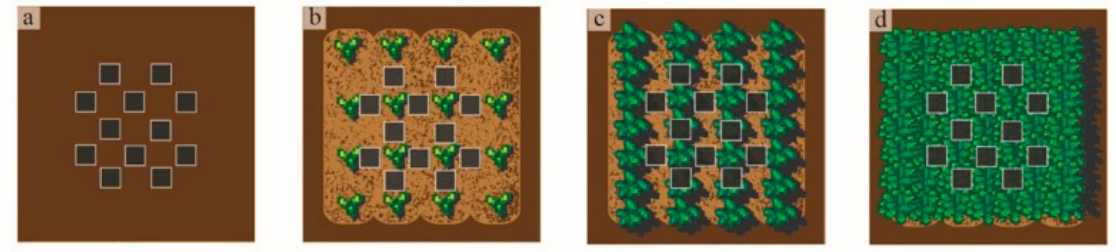
Figure 2. Arrangement of heat plate sensors on the ground for different growth stages (time progress) of a crop. To estimate G, under a given geometric configuration of heat plate sensors, modeling plant growth in a field crop is relatively straightforward based on their shape, geometric arrangement in the plot, and sun-sensor geometry. Thus, the value of G corresponding to any footprint with a given orientation and dimension is obtained as: